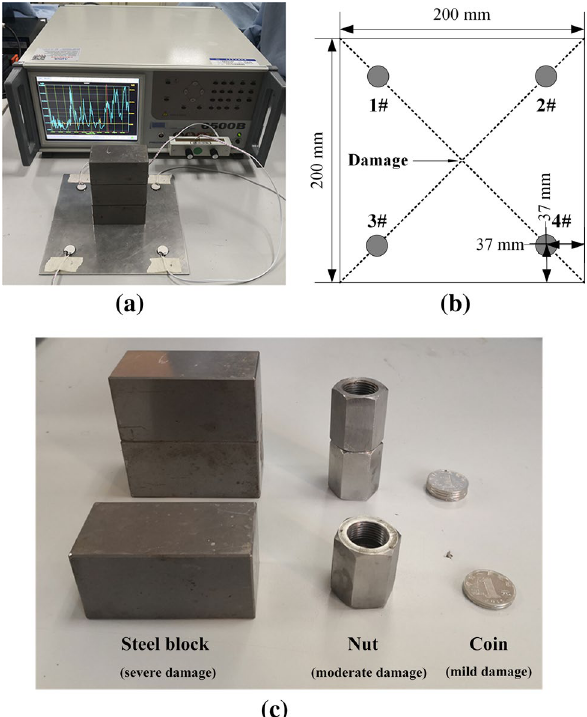
Figure 3. The experimental devices: ( a ) a WK6500B precision impedance analyzer and an aluminum plate with PZT whose layout diagram is shown in ( b ); ( c ) specimens used to simulate different cases of structural damages.